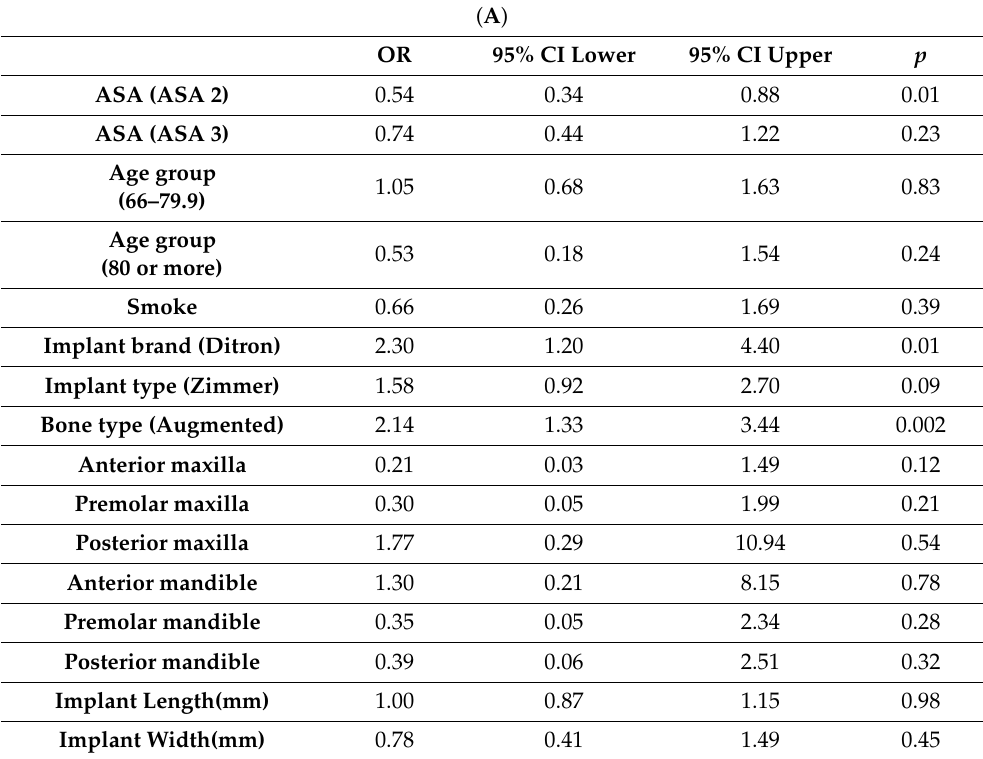
Table 3. ( A ). Binary Logistic regression coefficients (at the implant level) to predict implant failure. ( B ). Binary logistic regression coefficients (at the patient level) to predict implant